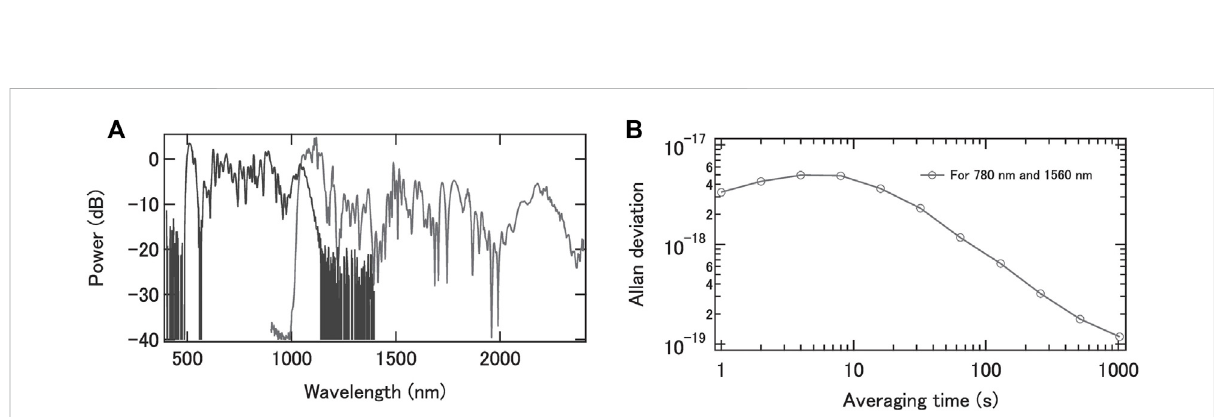
FIGURE 5 (A) Ultra-broadband coherently stitched supercontinuum generated with an Er-doped fi ber comb and a frequency-doubled Er-doped fi ber comb. (B) Frequency instability of the two-octave frequency comb measured for 780 nm and 1,560 nm. (from ref.